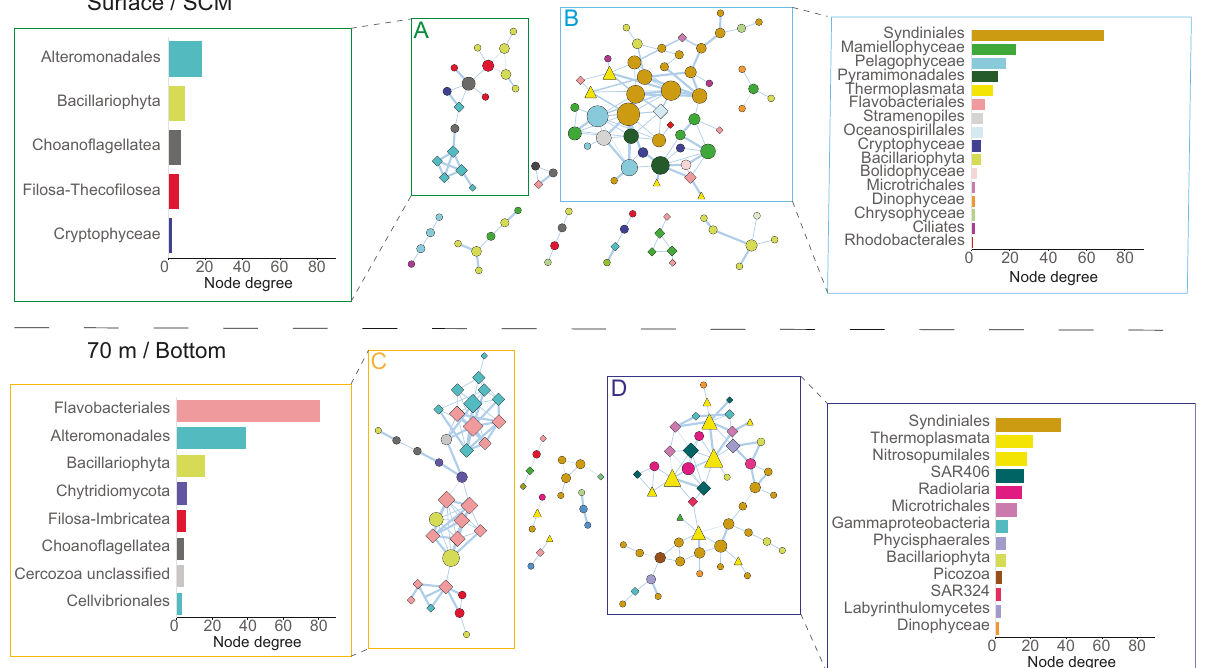
Fig. 5 Co-occurrence network analysis calculated on rDNA. The size of the nodes is proportional to the connexion degree and the size of the edges are proportional to the number of methods that supported the association of two nodes. The shape of the nodes indicates the following domain: Eukaryotes (circles); Archaea (triangles); Bacteria (diamonds). The barplots show the node degree distribution of each taxonomic group in the corresponding frame, with surface and SCM (upper section) and 70 meters and bottom samples (lower section). The framed boxes correspond to the regional clusters; central HB ( A ); Northwestern HB ( B ); deep Northwestern HB ( C ); deep central HB ( D ). Networks outside the framed boxes are smaller subnetworks, which are for information